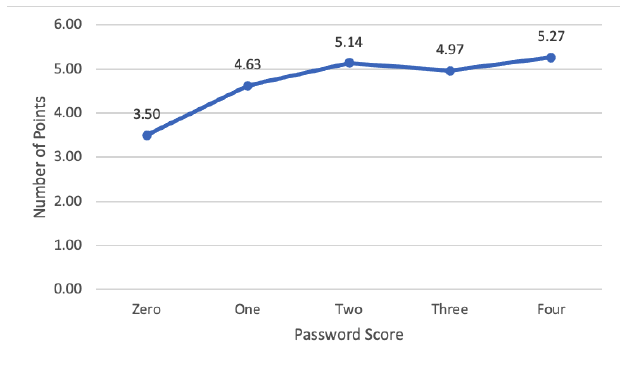
Figure 13. Password security knowledge scores for MTurk vs SONA.